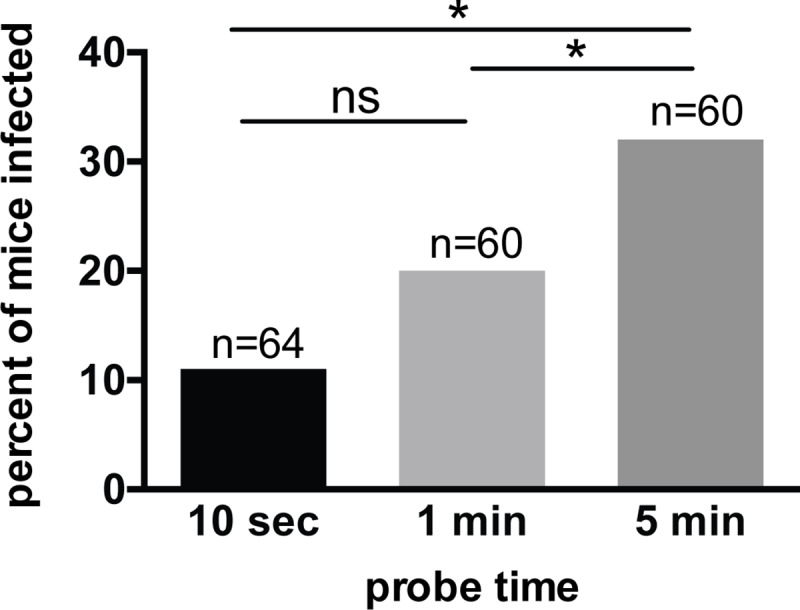
Mosquito probe time impacts the likelihood of malaria infection.Single-mosquito feeds were performed with the duration of probing experimentally manipulated at 10 seconds, 1 minute, or 5 minutes. Following this, salivary gland sporozoite loads were measured and mice were followed for blood stage malaria infection. There was a statistically significant association between probe time and probability of malaria infection (Fisher’s exact test p-0.020). Pair-wise comparisons were performed using logistic regression with odds of malaria infection as the outcome, probe time as a categorical predictor and robust variance. The results indicated statistically significant differences between 10 sec vs 5 min (p = 0.021) and 1 min vs 5 min (p = 0.025); while the comparison between the 10 sec vs 1 min groups did not reach statistical significance (p = 0.275). n = total number of mice in each group, pooled from 6 independent experiments with 10 to 15 mice per group per experiment. ns = not significant. See Methods and Materials for details on experimental design and statistical analyses.